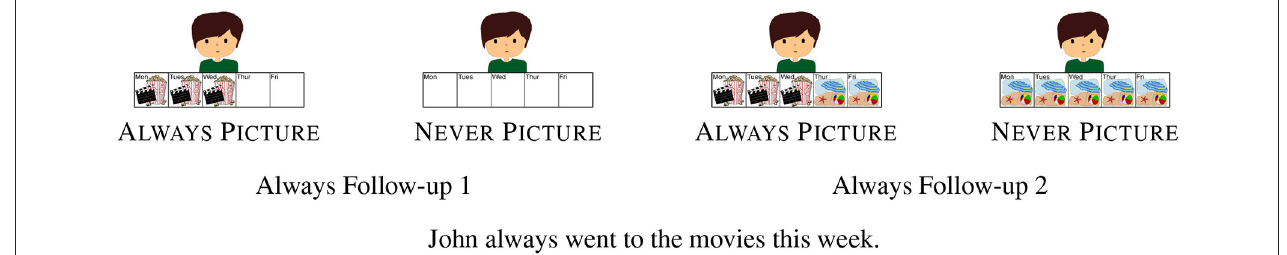
FIGURE 12 | Follow-up experiments on rejections of always